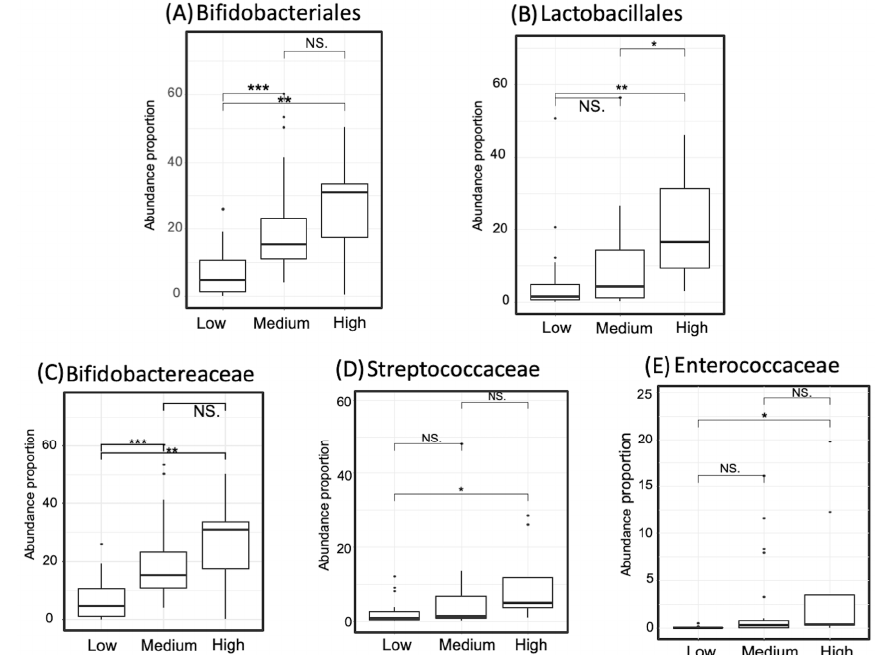
Figure 7. Proportion of the taxa that occurred abundantly in the high-gamma-aminobutyric acid (GABA) group. Two taxa at the order level, comprising Bifidobacteriales (Panel A ) and Lactobacillales (Panel B ), are displayed. Three taxa at the family level are demonstrated incorporating Bifidobacteraceae (Panel C ), Streptococcaceae (Panel D ), and Enterococcaceae (Panel E ). Significance codes: < 0.001 ***, < 0.01 **, < 0.05 *, < 0.1 “NS”.